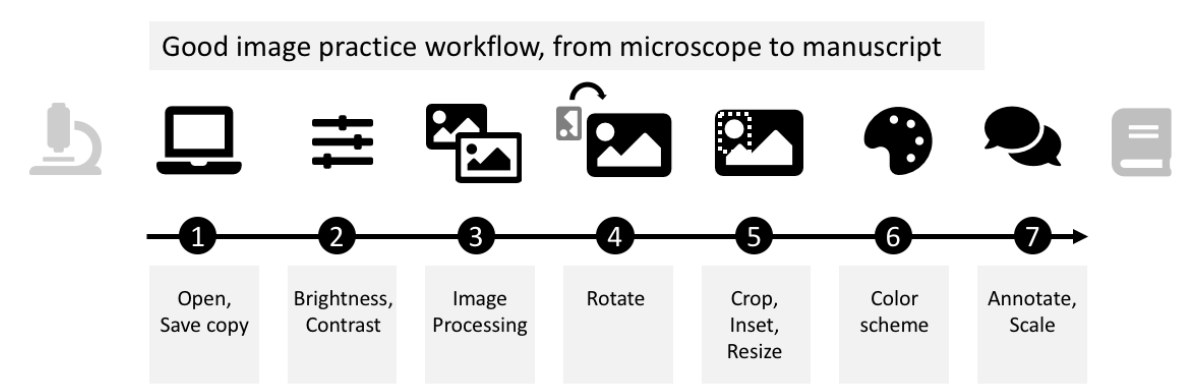
Figure 1. Schematic of the image processing workflow from microscope to